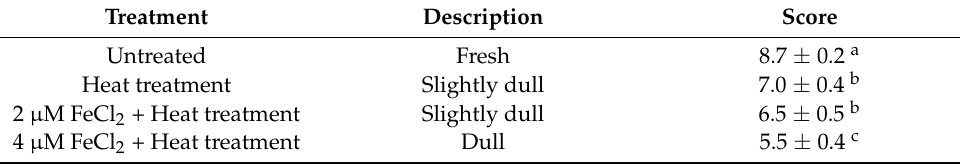
Table 1. Effect of Fe 2+ on aroma quality of green tea infusion with heat